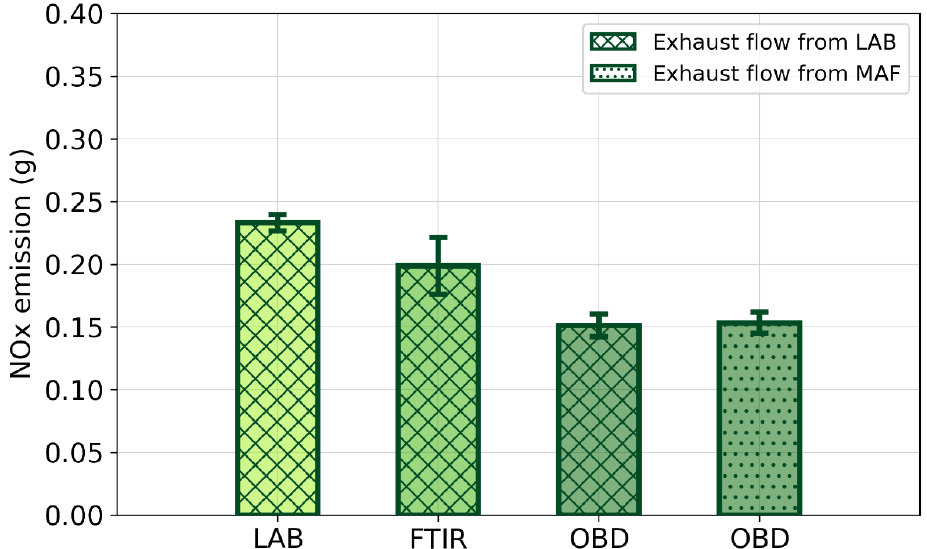
Figure 5. Vehicle 1 average of the cumulative NOx emissions measured at tailpipe with different methods over two different hot WLTC cycles. LAB, FTIR and OBD indicate that the NOx concentration used was measured with standard laboratory equipment, a lab-grade FTIR spectrometer or the on-board NOx sensor, respectively. The two different pattern fills indicate which exhaust flow measurement was used, as indicated in the legend.